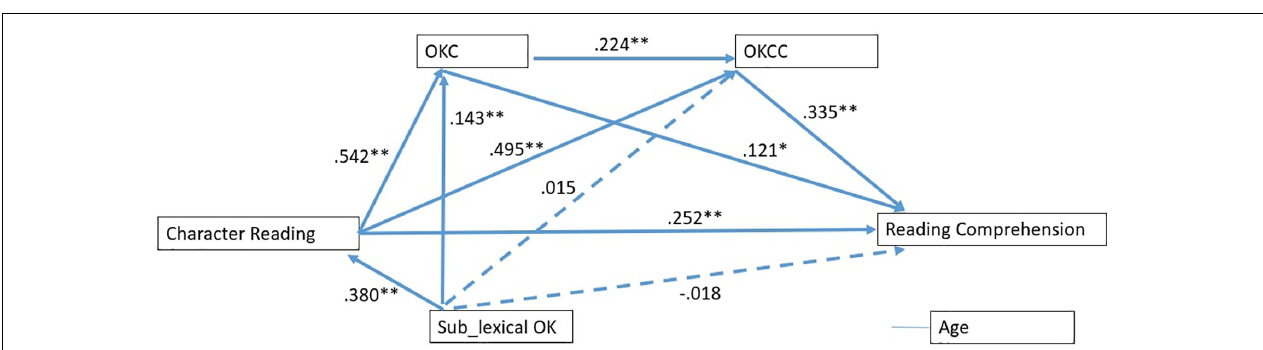
FIGURE 2 | Path model demonstrating relationship between character reading and reading comprehension in the low-experienced group. ** p < 0.01, * p < 0.05. † Represents marginally significant ( p = 0.053). All values were standardized coefficients. OKC, lexical orthographic choice; OKCC, lexical orthographic choice in context.